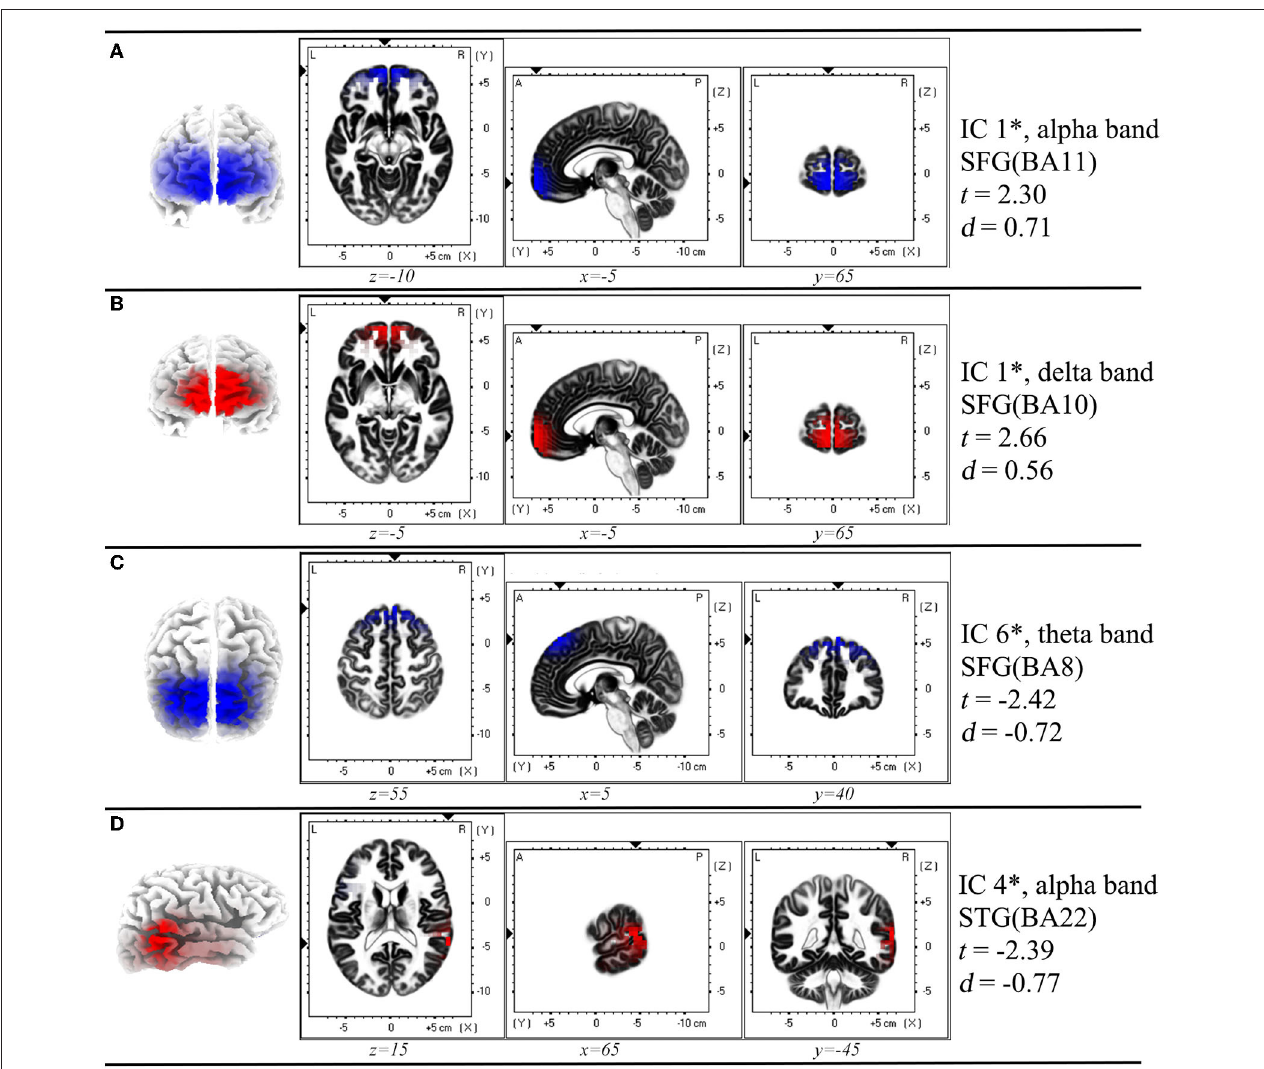
FIGURE 2 | Spatial profile corresponding to the functional independent component that has significant difference in each comparison in Figure 1 * . (A) Inter-ictal EEG compared with the resting-state EEG data of HC group; (B) Pre-ictal EEG was compared with inter-ictal EEG within AE group; (C) Post-ictal EEG was compared with inter -ictal EEG within AE group; (D) Post-ictal EEG compared with pre -ictal EEG within AE group. In each row of figure, the left panel showed the macro location of each IC. In the middle panel, the small triangles along the coordinate axes indicate the maximum electric neuronal activity, and the corresponding peak coordinates are displayed in the lower part of each intercepted image. In the right panel, the IC number, frequency band, location and Cohen’s d values were presented. * P < 0.05, two sample t- test between AE group and HC group, and paired t -test for different states within AE group. IC, independent component; SFG, superior frontal gyrus; STG, superior temporal gyrus; BA, Brodmann area; t , t -value of t -test; d , Cohen’s d -value. The location assignments were shown in MNI space (MNI152-2009c gray